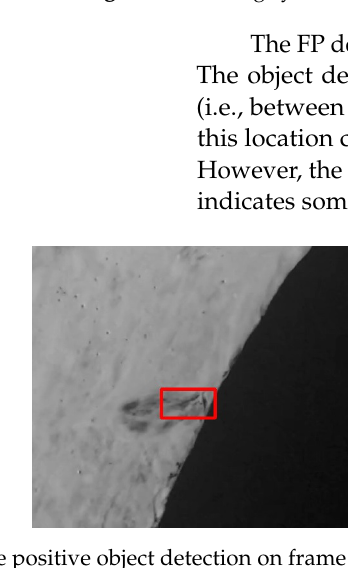
Figure 9. Tracking system removed detection jitter and predicted smooth tracking boxes.